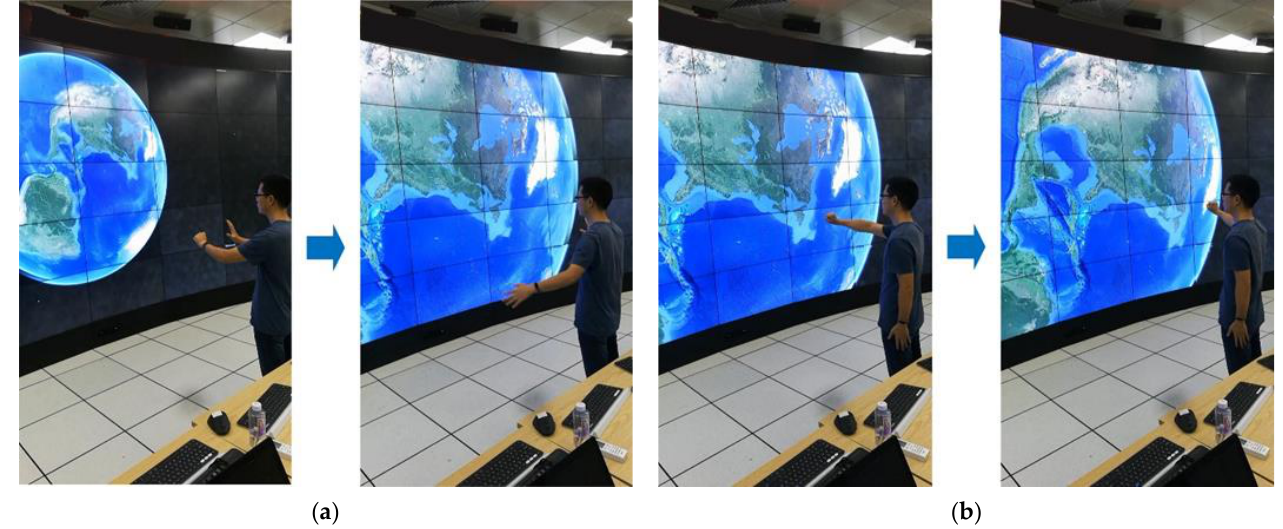
Figure 12. Navigation task interactive operation. ( a ) Zoom operation. ( b ) Rotation operation.